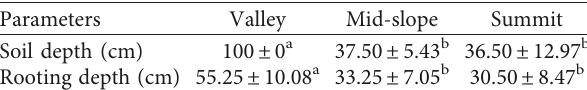
Table 3: Comparison between soil depth and rooting depth at different elevations (the values are means and their associated standard error).